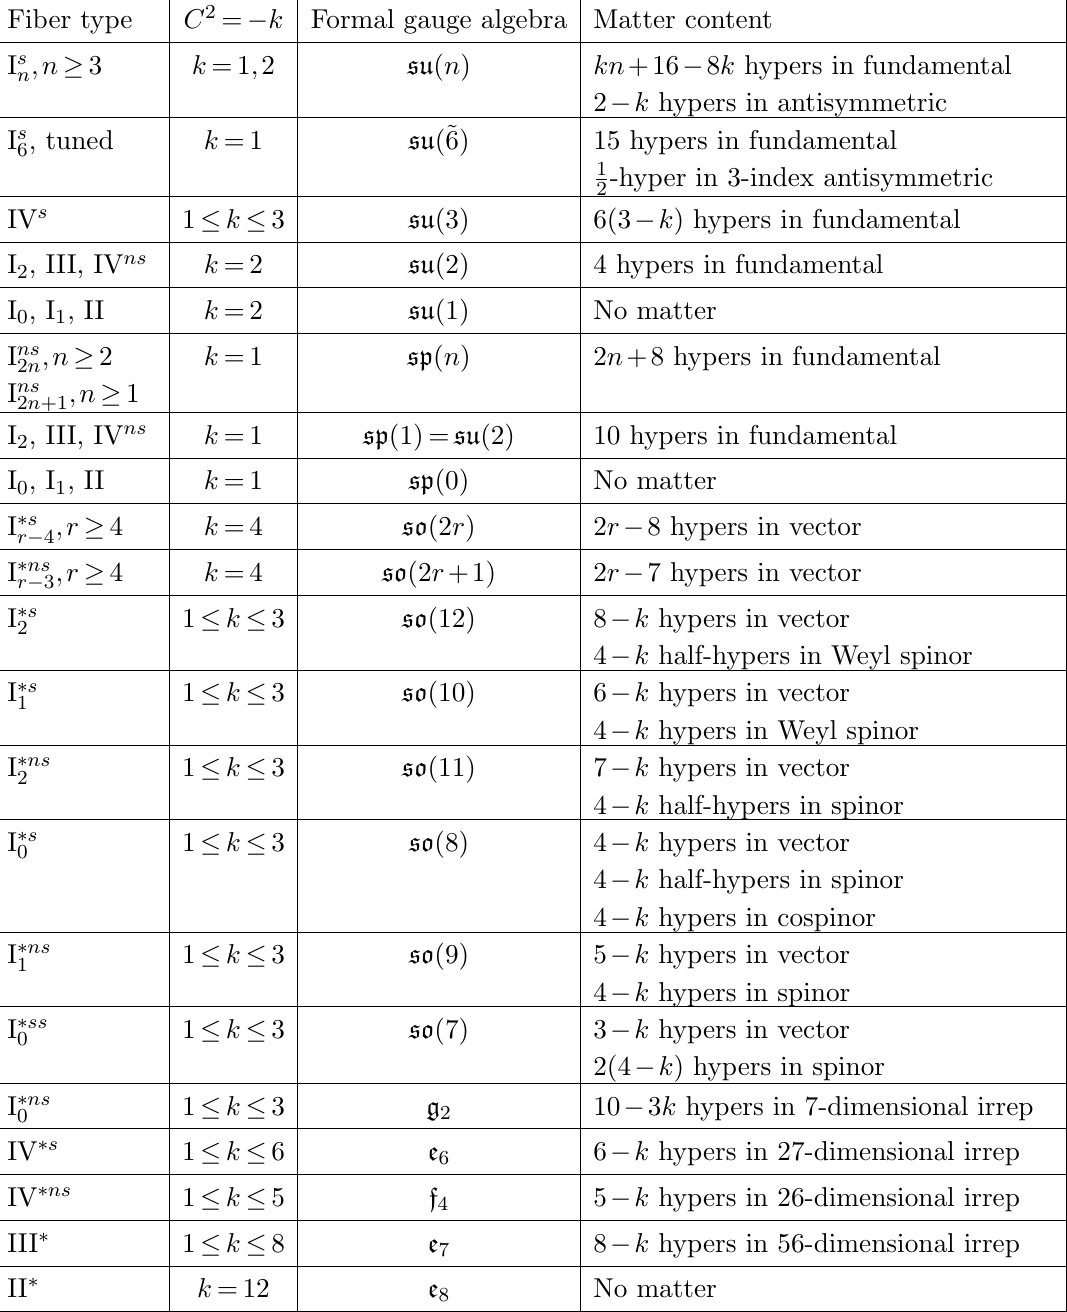
Table 1 . We assign a formal gauge algebra to each Kodaira-Tate (cid:12)ber type. A tuned version